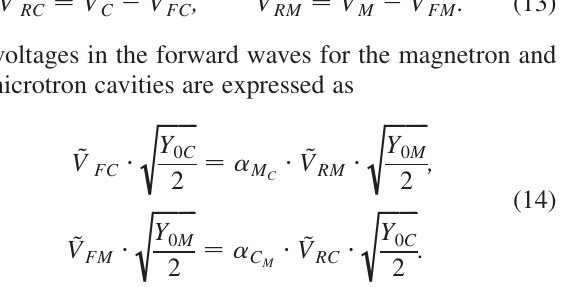
FIG. 9. (Color) Calculated (solid lines) and measured (bold solid lines with error bars) deviations of the magnetron frequency in the magnetron-accelerating cavity system, left scale, at various values of the magnetron-accelerating cavity detuning parameter, " . 1— " ¼ 0 : 47 , 2— " ¼ 0 : 74 , 3— " ¼ 0 : 93 , and 4—plot of the measured incremental magnetron current, right